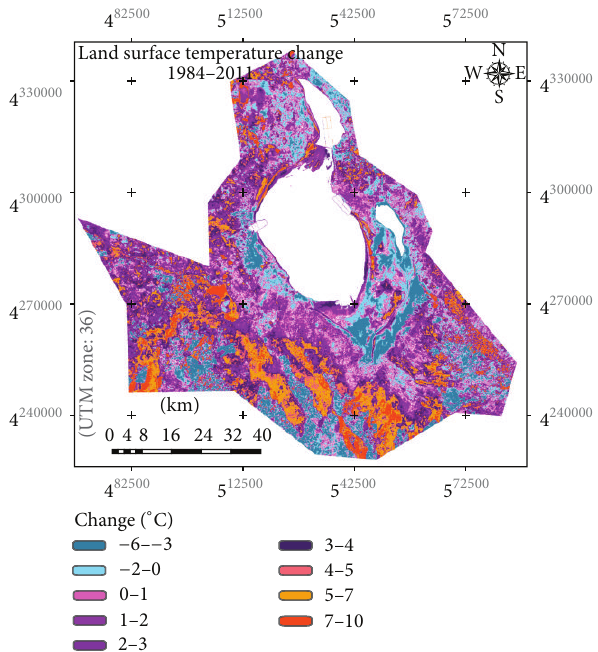
Figure 6: Presentation of LST difference for a 27-year period over Salt Lake Basin